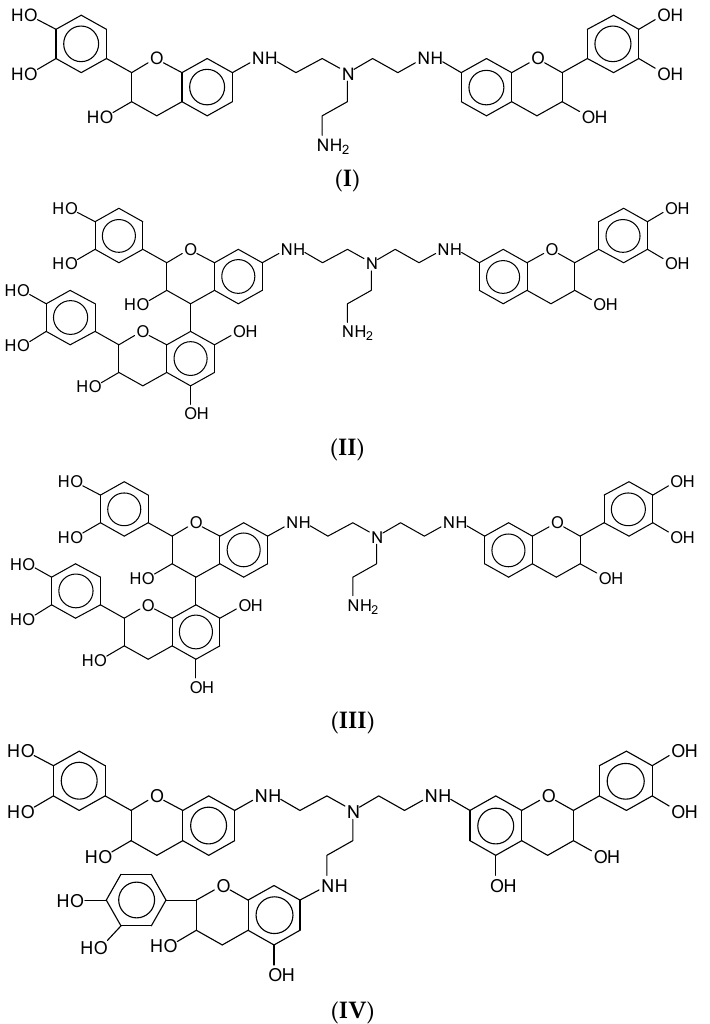
Figure 6. Chemical species ( I – IV ) are formed by the reaction of flavonoid units with the free triamine noy yet involved in the hyperbranched network.